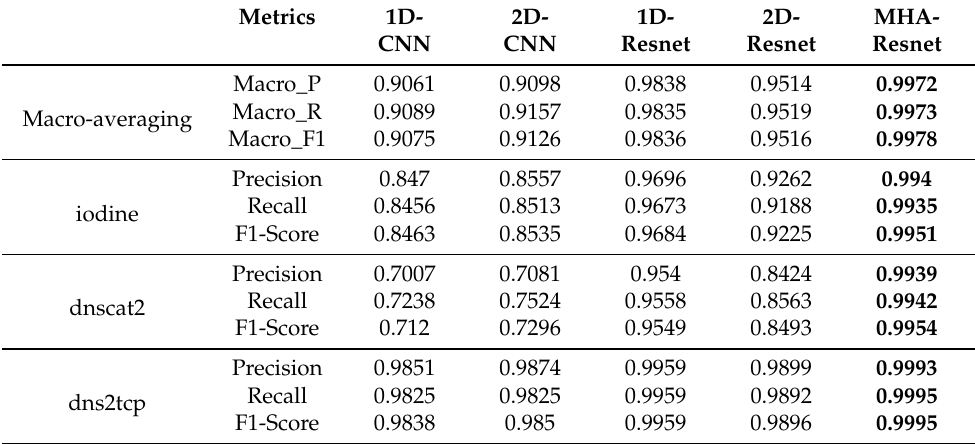
Table 6. MHA-Resnet vs. Baseline